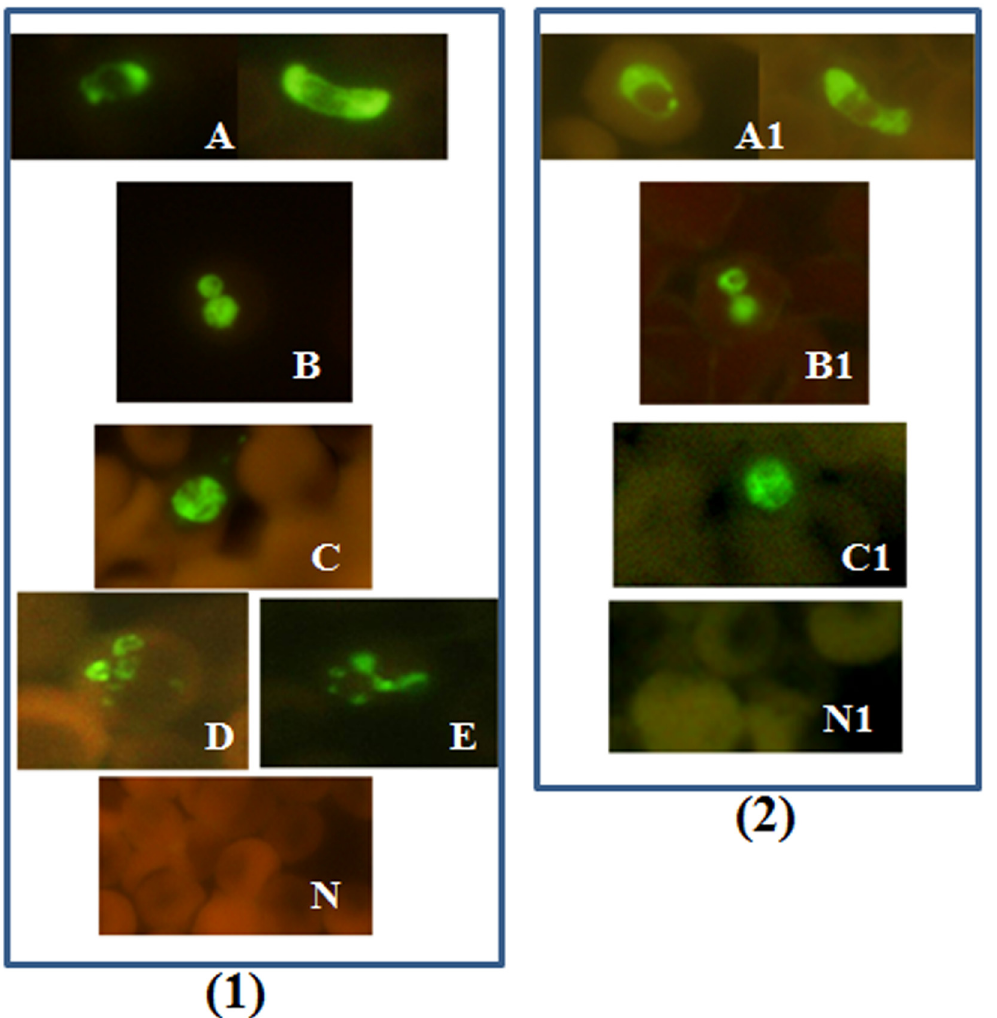
Fig 1. Blood smears tested with Plasmodium genus FISH assay. Blood smears from different Plasmodium species P . falciparum , P . vivax , P . knowlesi , P . ovale and P . malariae were analyzed using Plasmodium genus FISH assay. (1) All the processed smears were read with a 100X objective in a fluorescence microscope. (2) P . falciparum . P . vivax , P . knowlesi and negative control smears were read with a 100X objective on a regular microscope with a LED unit. Green fluorescence indicates the presence of Plasmodium ribosomal RNA (rRNA). (A) P . falciparum including crescent shaped gametocytes (B) P . vivax ; (C) P . knowlesi ; (D) P . ovale ; (E) P . malariae ; and (N) Negative Control ; (A1) P . falciparum ;. (B1) P . vivax ; (C1) P . knowlesi ; and (N1) Negative Control